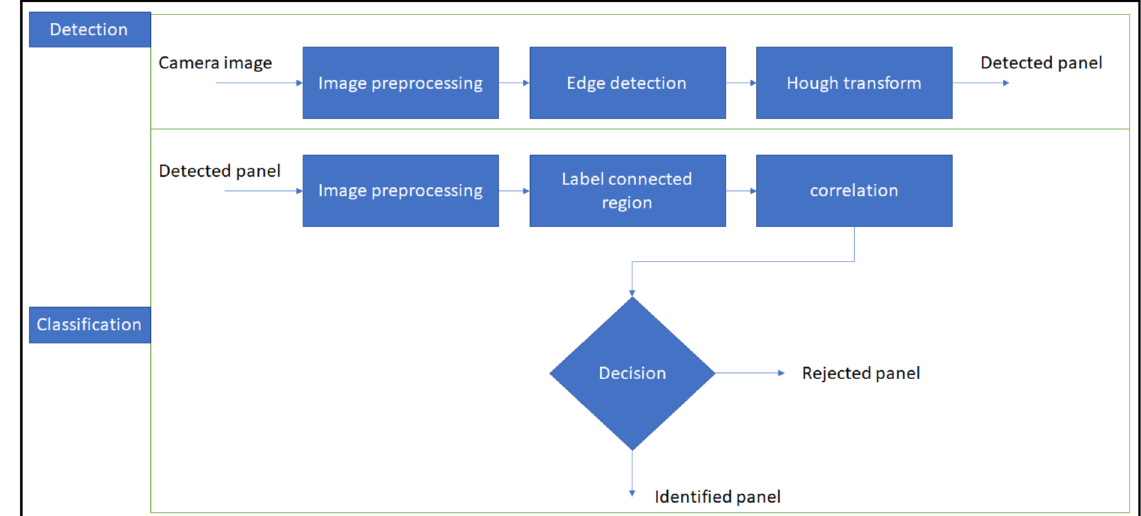
Figure 7. TSR algorithm [27].